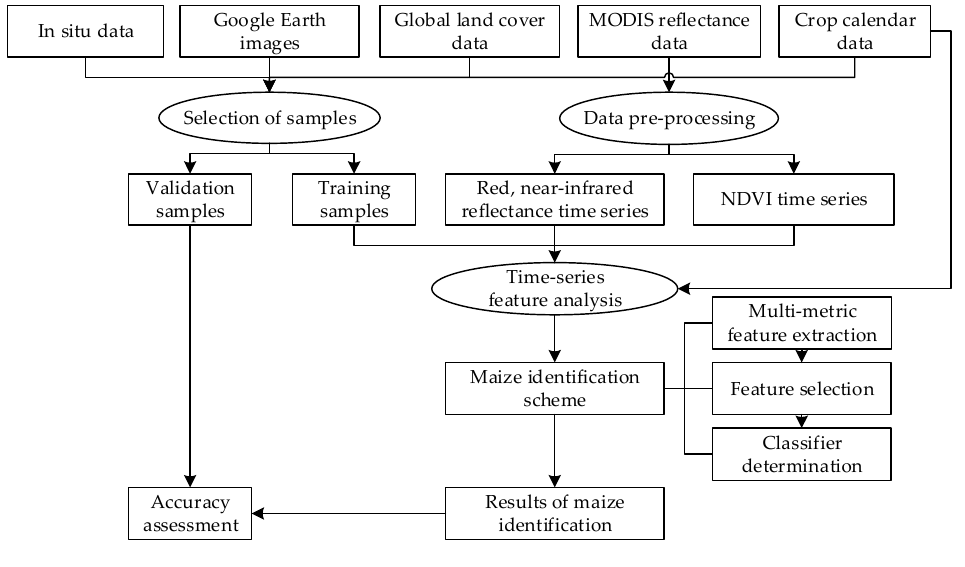
Figure 2. Flowchart of maize identification.